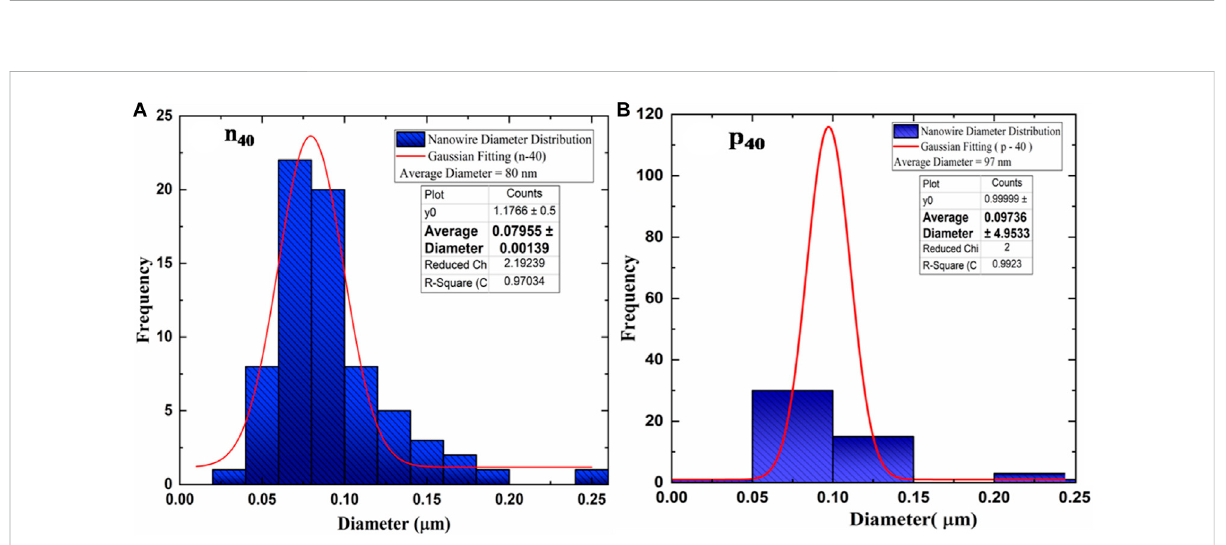
FIGURE 4 Average diameter of the Si NWs (A) n 40 and (B) p 40 using ImageJ